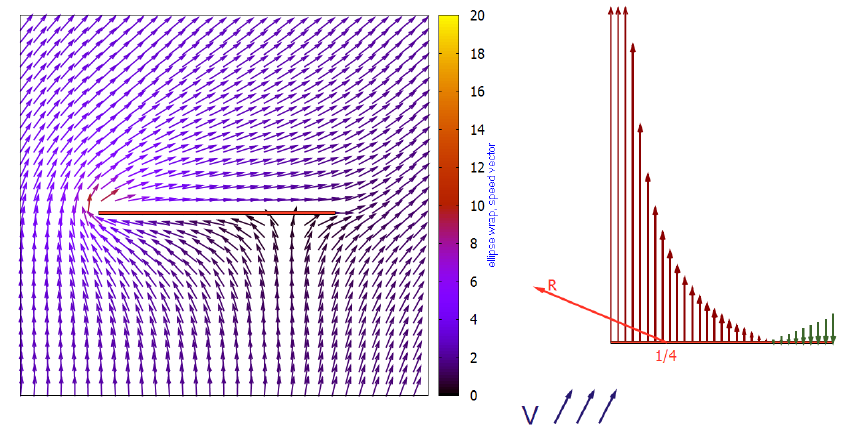
Fig. 12. Velocity field and distribution of the pressure coefficient of the fluid flow around the plate. The center of pressure of the flow on the plate is raised a quarter of its length from the leading edge, and the position of the center of pressure does not depend either on the flow velocity or on the angle of